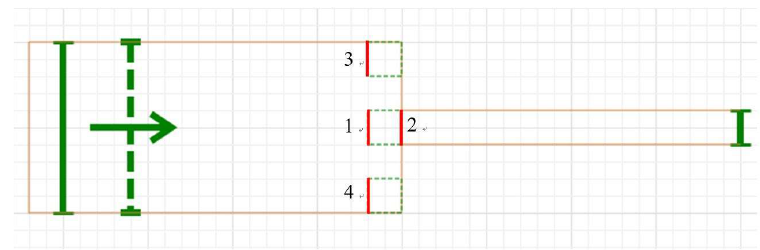
Figure 5. Setting of speed detection lines.